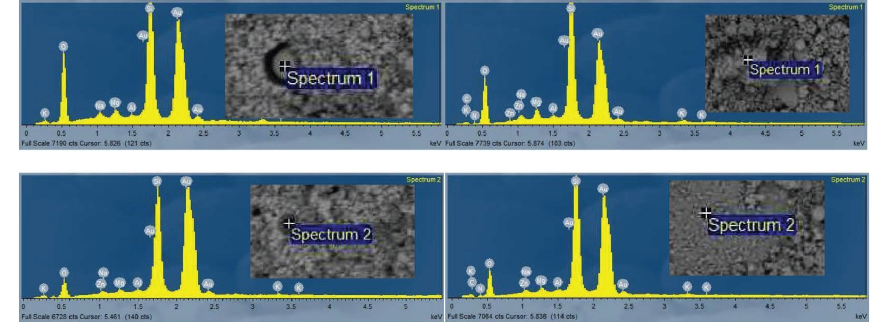
Figure 12: EDX spectra of samples with and without rubber